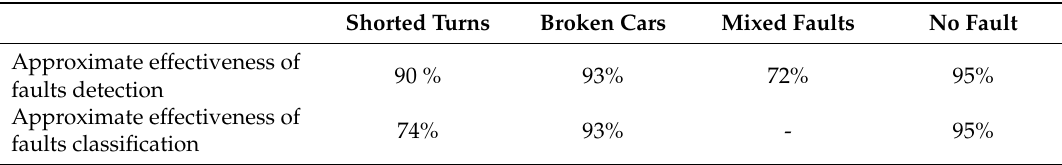
Table 3. Effectiveness of Kohonen network in fault detection and classification. Shorted Turns Broken